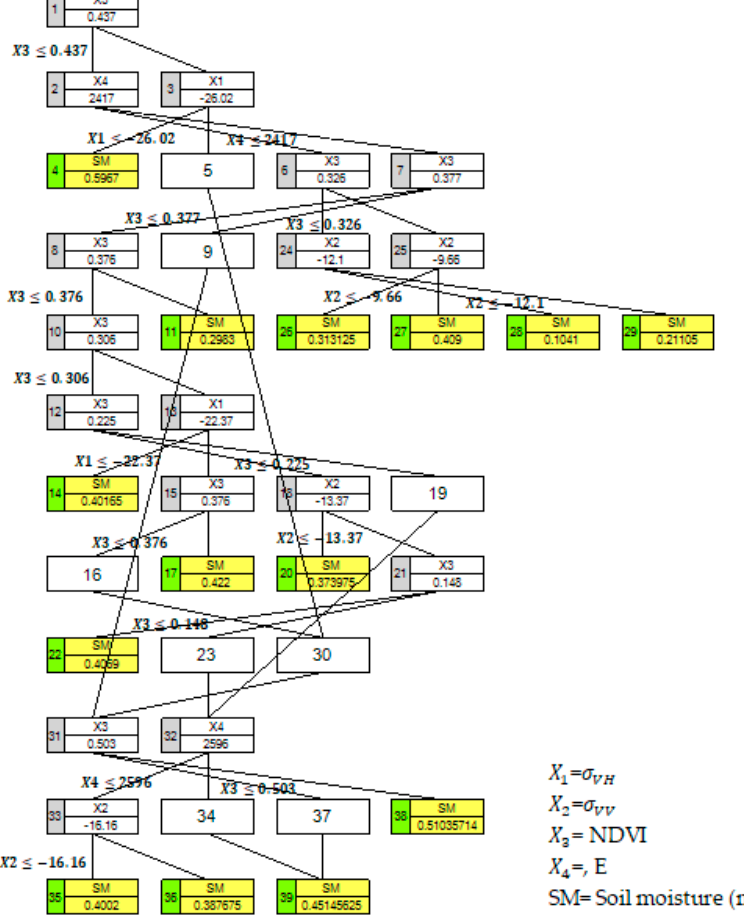
Figure 5. The optimal SCA tree with significance level α = 0.05 for AWS observed soil moisture. The boxes are called as nodes (total nodes = 39). The nodes with green and yellow colors are tip clusters (14) which basically contains the prediction